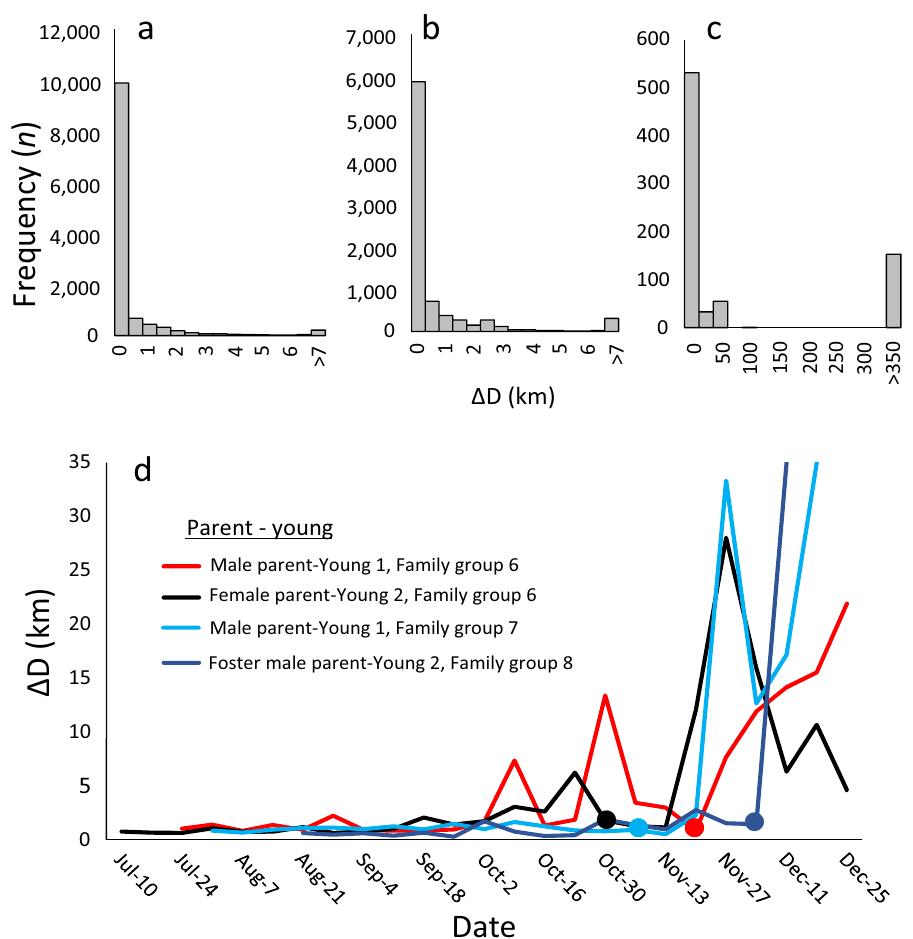
Fig. 2 Bonds between experienced adult Caspian terns and naïve young during migration and after arrival on the wintering grounds. Histograms show the distribution of pairwise distances ( Δ D) between the adult and the young migrating together from a , the onset of migration until arrival in the wintering area ( n = 12,249), b in the wintering area until the breakup of the parental bond ( n = 8242), and c after the breakup of the parental bond ( n = 773). d The average weekly distance between the parent and young (family and ID of parent-young is given in the inserted legend, cf. Supplementary Table 1) from onset of migration until December 31 st among pairs successfully arriving in the wintering area ( n = 4). Filled-in circles indicate the breakup date (mean ± s.e.) for each pair as judged from segmented regressions (Male parent-Young 1, Family group 6: 25-Nov ±3 days ( p < 0.0001); Female parent- Young 2, Family group 6: 30-Oct ±5 days ( p < 0.0001); Male parent-Young 1, Family group 7: 12-Nov ±2 days ( p < 0.0001); Foster male parent-Young 2, Family group 8: 6-Dec ±0 days ( p <